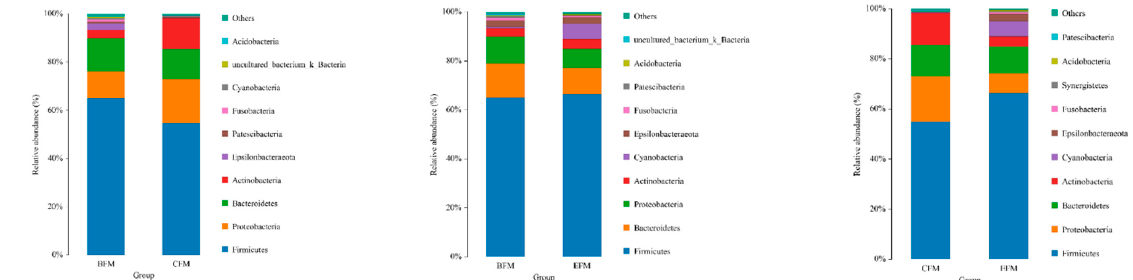
Figure 7. Microbial relative abundance at the phylum level. BFM: fecal microbiota before the experiment; CFM: fecal microbiota in the counterpart group after the experiment; EFM: fecal microbiota in the experimental group after the experiment.